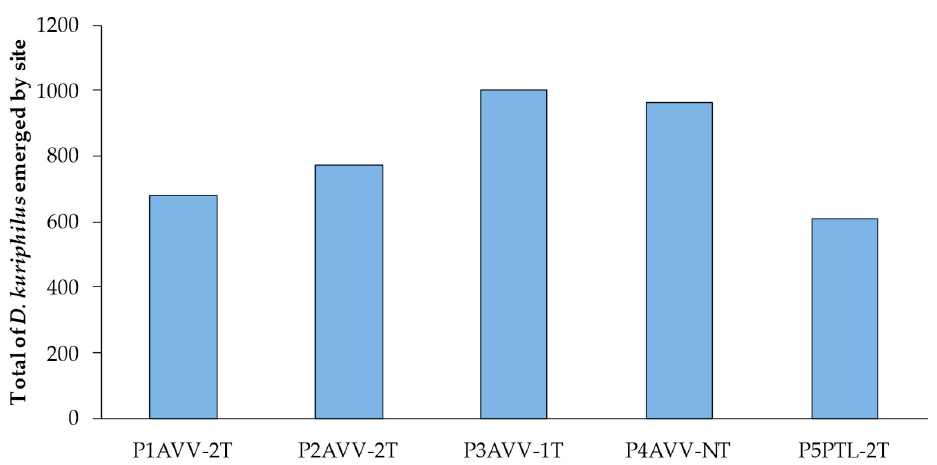
Figure 5. Total number of D. kuriphilus adults emerged in 2018. P1 to P5—orchard reference number; Table 4. Absolute and relative values of spring galls parasitized by T. sinensis and autochthonous parasitoids in five chestnut orchards in Minho (P1 to P5) located in Arcos de Valdevez (AVV) and Ponte de Lima (PTL), with one (1T), two (2T) or no treatment (NT) of T. sinensis (NT) in 2018.